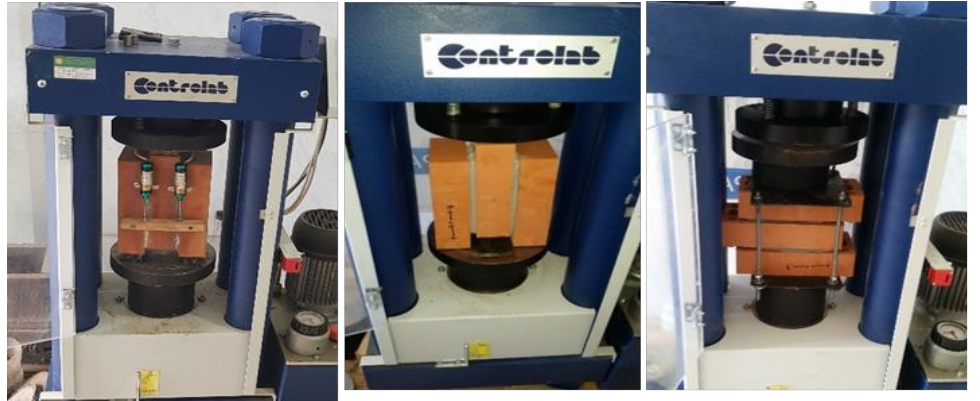
Figure 3. Experimental setup of masonry shear triplets.